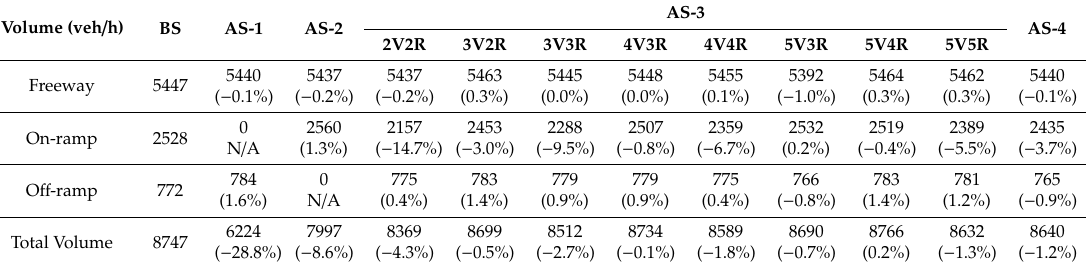
Table 4. Volume throughput results of each